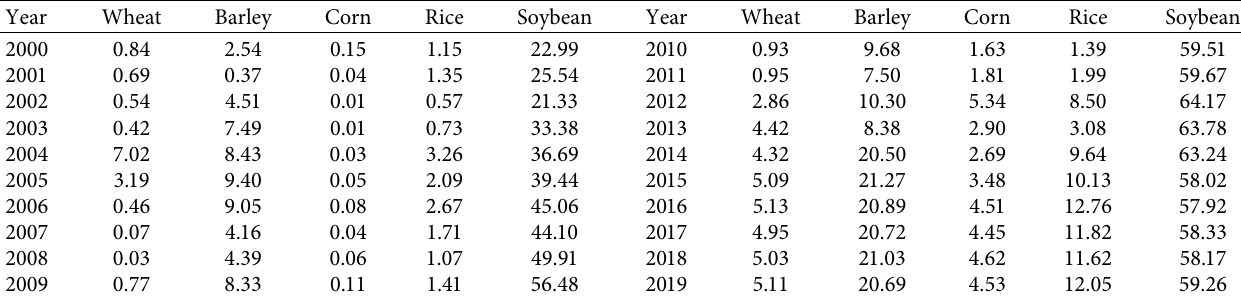
Table 1: The proportion of China’s major grain imports in global main grain imports (unit: percent). Year Wheat